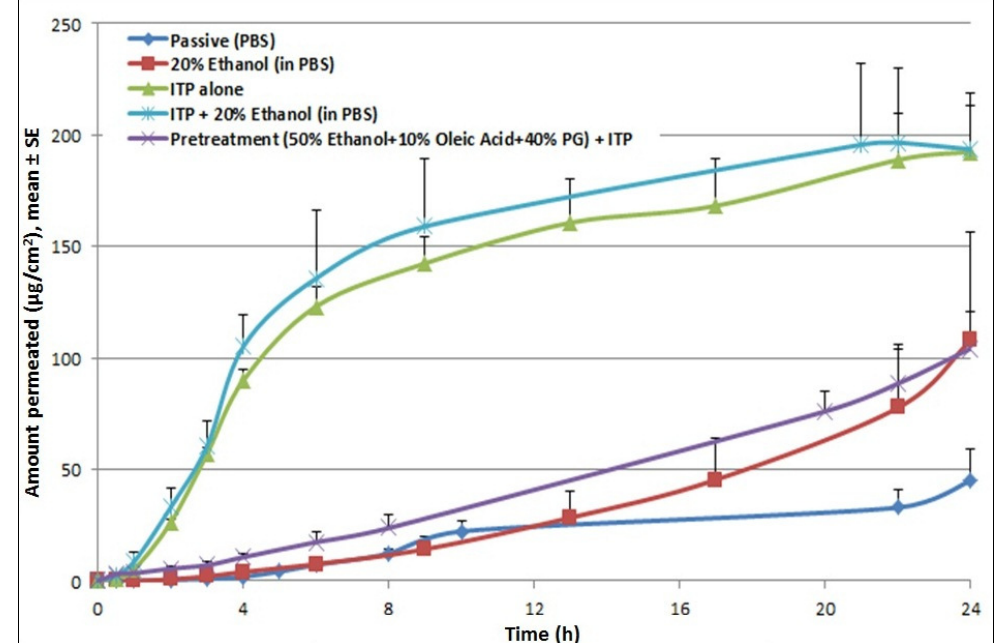
Figure 4. Effect of iontophoresis on transdermal delivery of cyanocobalamin; iontophoresis significantly increased the cumulative amount delivered across